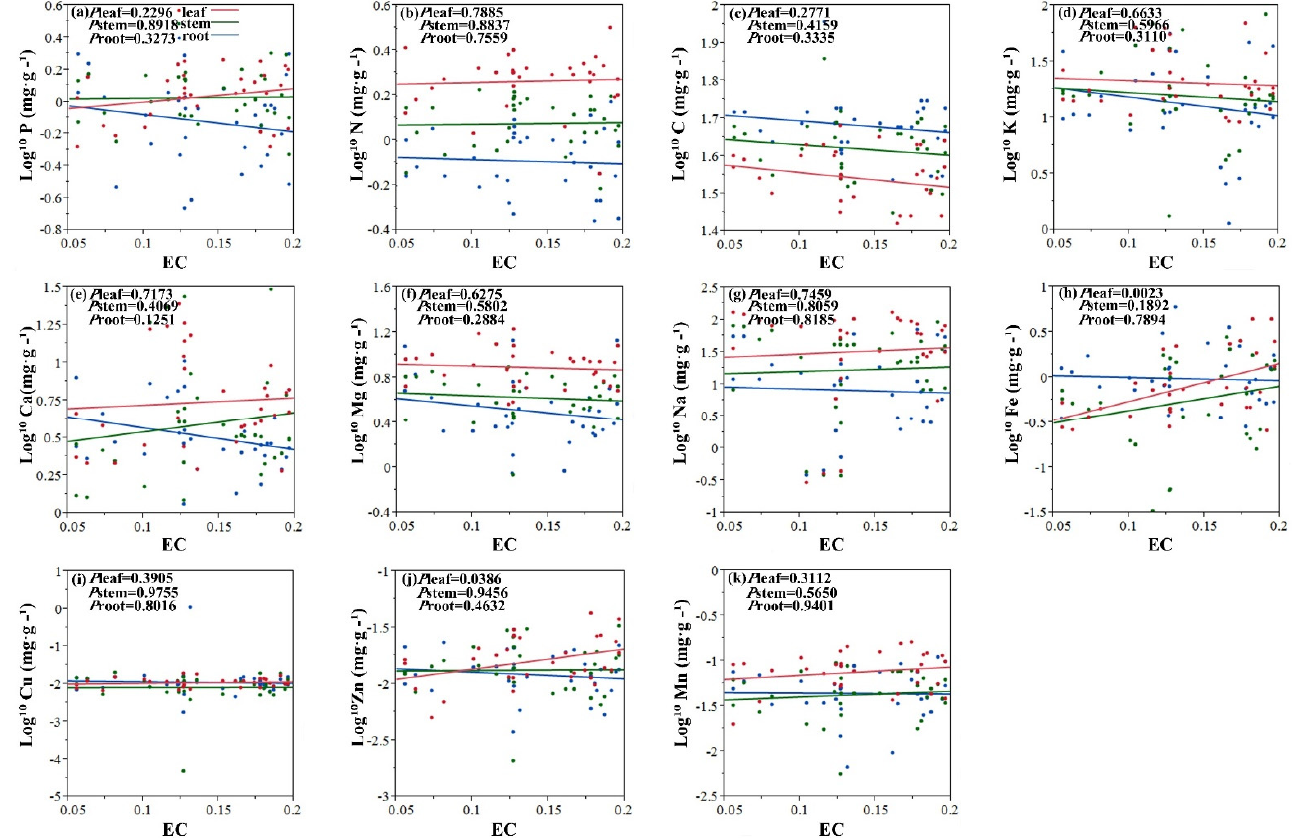
Figure 1. Linear relationships of EC (dS m − 1 ) with concentration of 11 elements among leaves, stems and roots. Colored lines represent significant relationships ( p < 0.05) for halophytes (red, leaves; blue, stems; green, roots). ( a ) Linear relationship between log 10 P (mg g − 1 ) and EC. ( b ) Linear relationship between log 10 N (mg g − 1 ) and EC. ( c ) Linear relationship between log 10 C (mg g − 1 ) and EC. ( d ) Linear relationship between log 10 K (mg g − 1 ) and EC. ( e ) Linear relationship between log 10 Ca (mg g − 1 ) and EC. ( f ) Linear relationship between log 10 Mg (mg g − 1 ) and EC. ( g ) Linear relationship between log 10 Na (mg g − 1 ) and EC. ( h ) Linear relationship between log 10 Fe (mg g − 1 ) and EC. ( i ) Linear relationship between log 10 Cu (mg g − 1 ) and EC. ( j ) Linear relationship between log 10 Zn (mg g − 1 ) and EC. ( k ) Linear relationship between log 10 Mn (mg g − 1 ) and